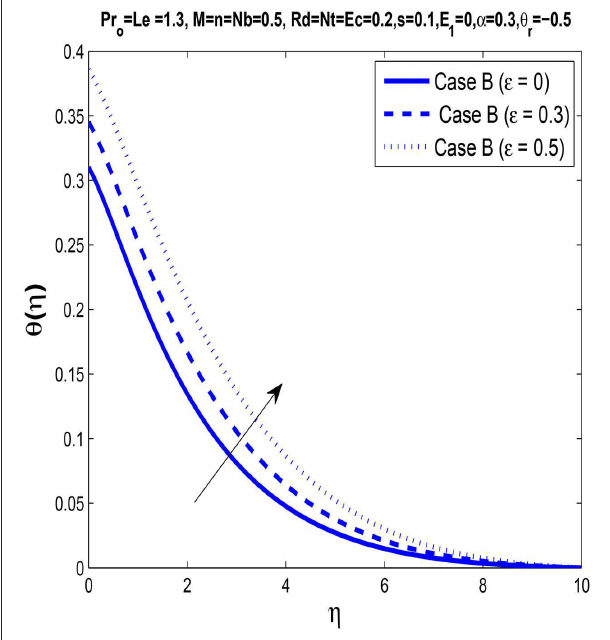
FIGURE 11 | Concentration profile φ ( η ) for different values of Nt . FIGURE 12 | Temperature profile θ ( η ) for different values of ǫ